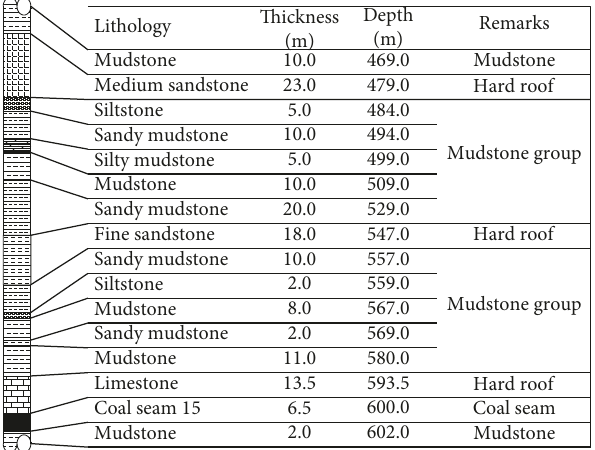
Figure 2: Generalized stratigraphic column.